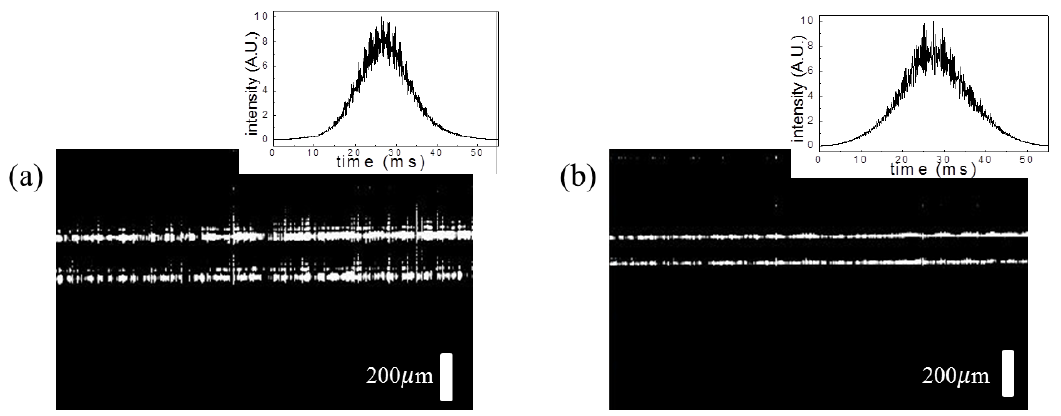
Figure 7. 2-D optical coherence tomography (OCT) images of a cover glass sample with ( a ) a sinusoidal; and ( b ) a triangular drive function. Insets show the original interferogram of an A-scanning axial image.